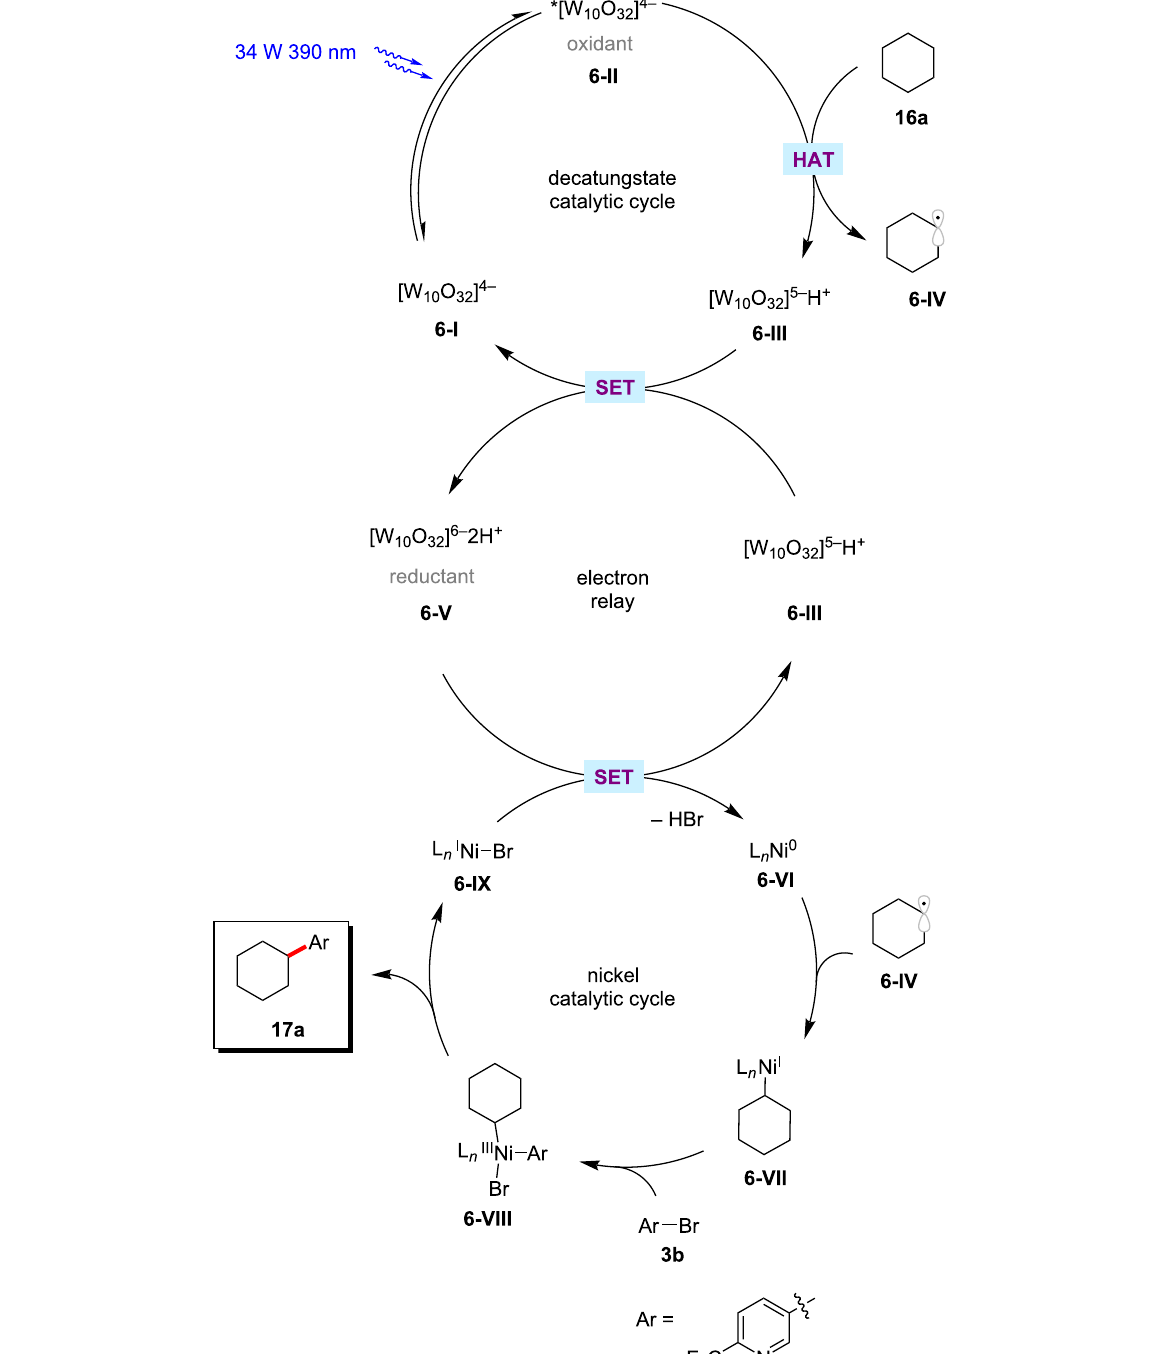
by disproportionation of the singly reduced decatungstate 6-III